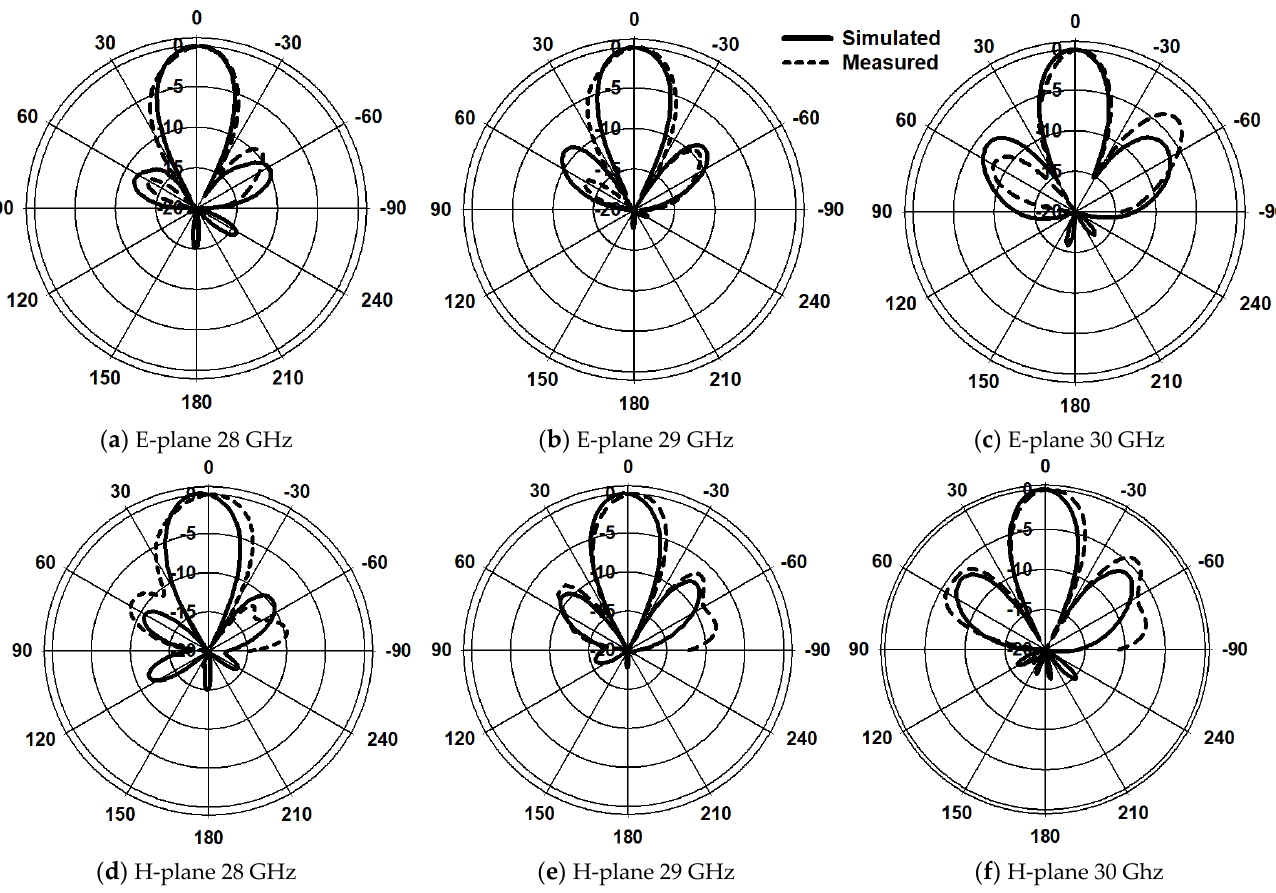
Figure 21. Simulated and measured radiation patterns across the CP bandwidth of the DRA array. Table 5. Comparison of the proposed antenna performance with those of previously published designs.